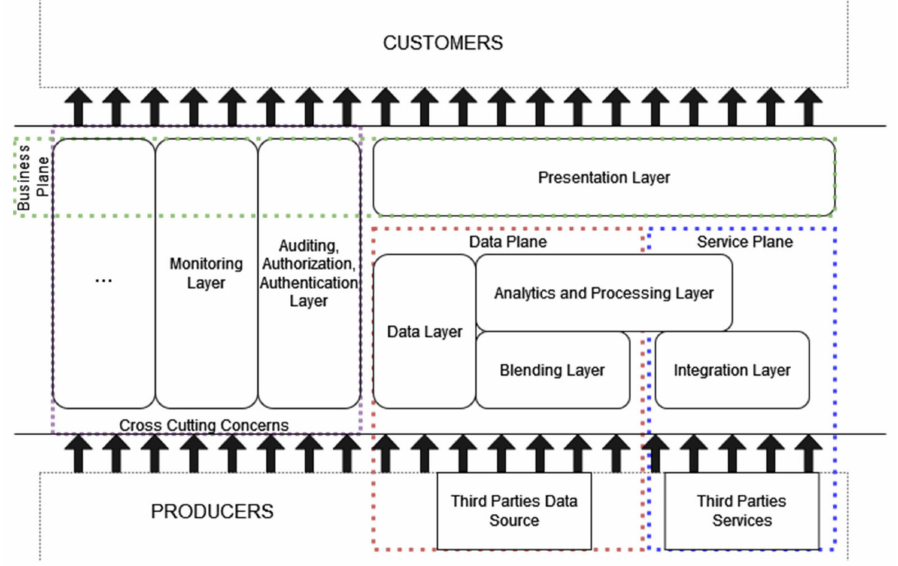
Figure 2. APERTO5.0 layers more detailed view. All components are put together for a more comprehensive effort of integration and synergic